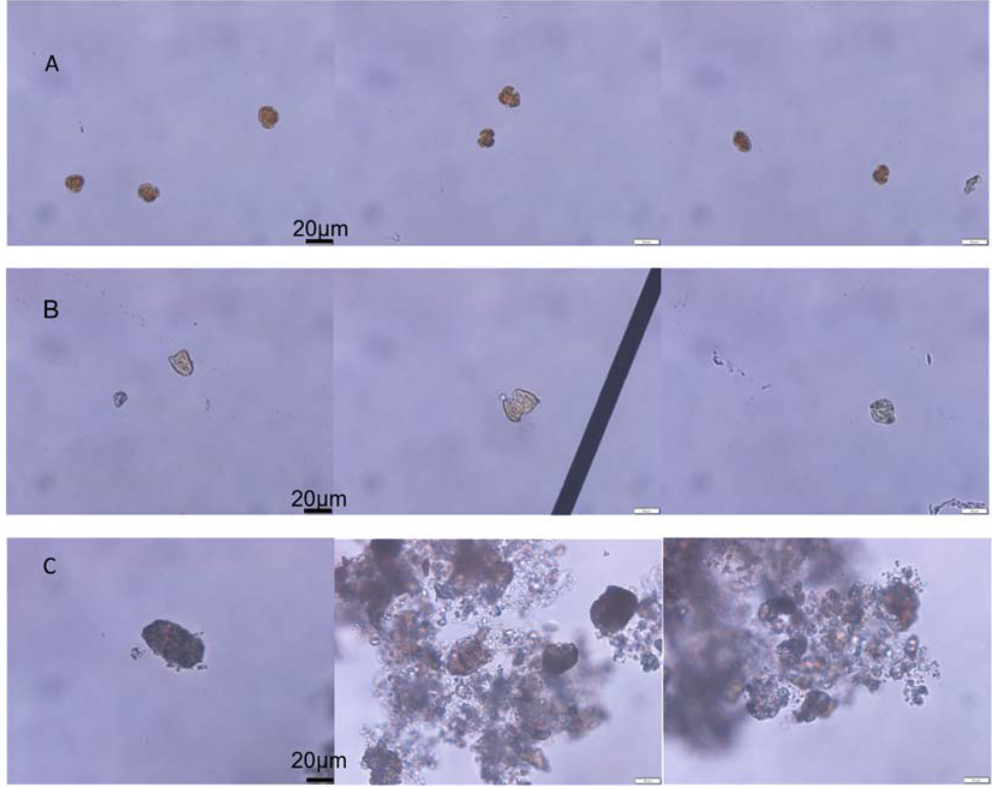
Figure 1. The effect of MC on the cell morphology of K. mikimotoi. ( A ) Morphology of the normal algal cell. ( B ) Morphology of the residual algal cells exposed by MC. ( C ) Morphology of the algae cells flocculated exposed by MC.